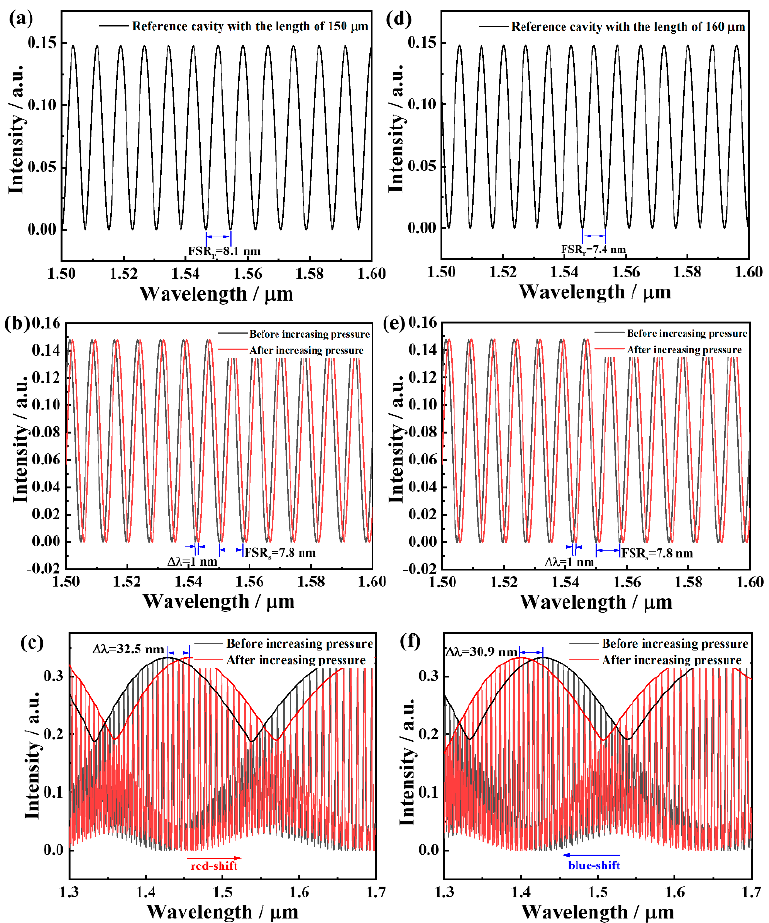
Figure 9. Simulated wavelength shift of pressure response. ( a – c ) The reflection spectra of the single reference cavity (150 µ m), single sensing cavity (155 µ m), and paralleled F–P cavities. ( d – f ) The reflection spectra of the single reference cavity (160 µ m), single sensing cavity (155 µ m), and paralleled F–P cavities.